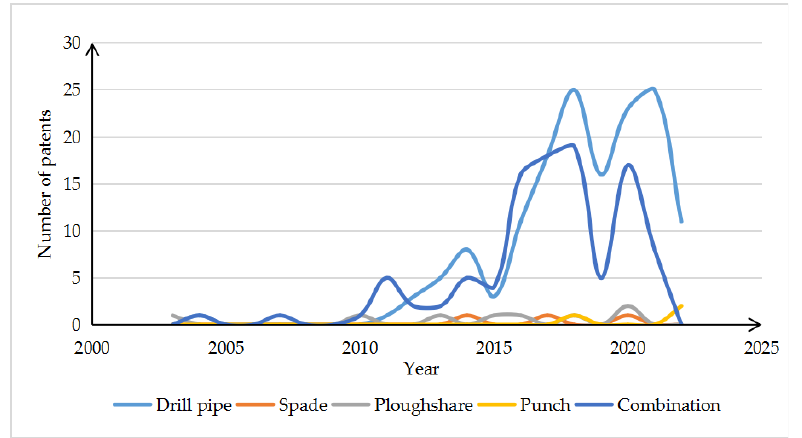
Figure 16. Patent Analysis of the drill pole tree-planting machine. Figure 16. Patent analysis of the drill pole tree-planting machine.